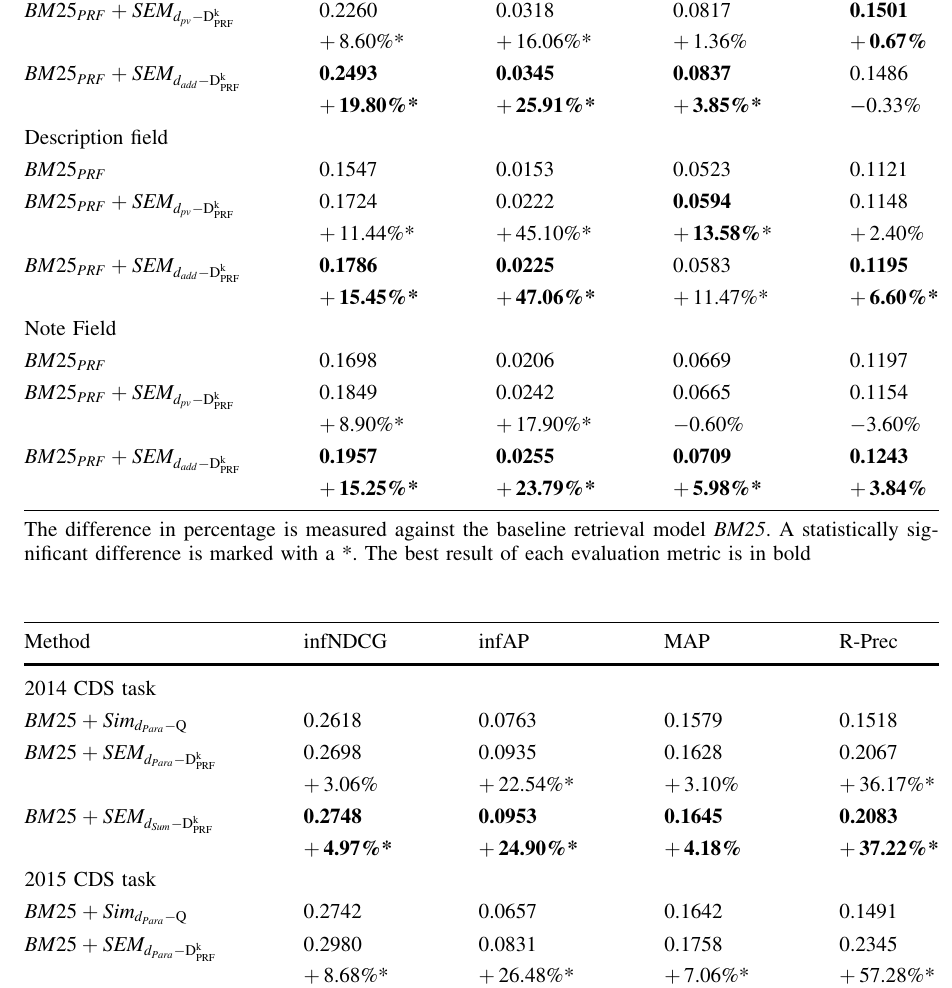
Table 4 Evaluation results on the TREC 2016 CDS task